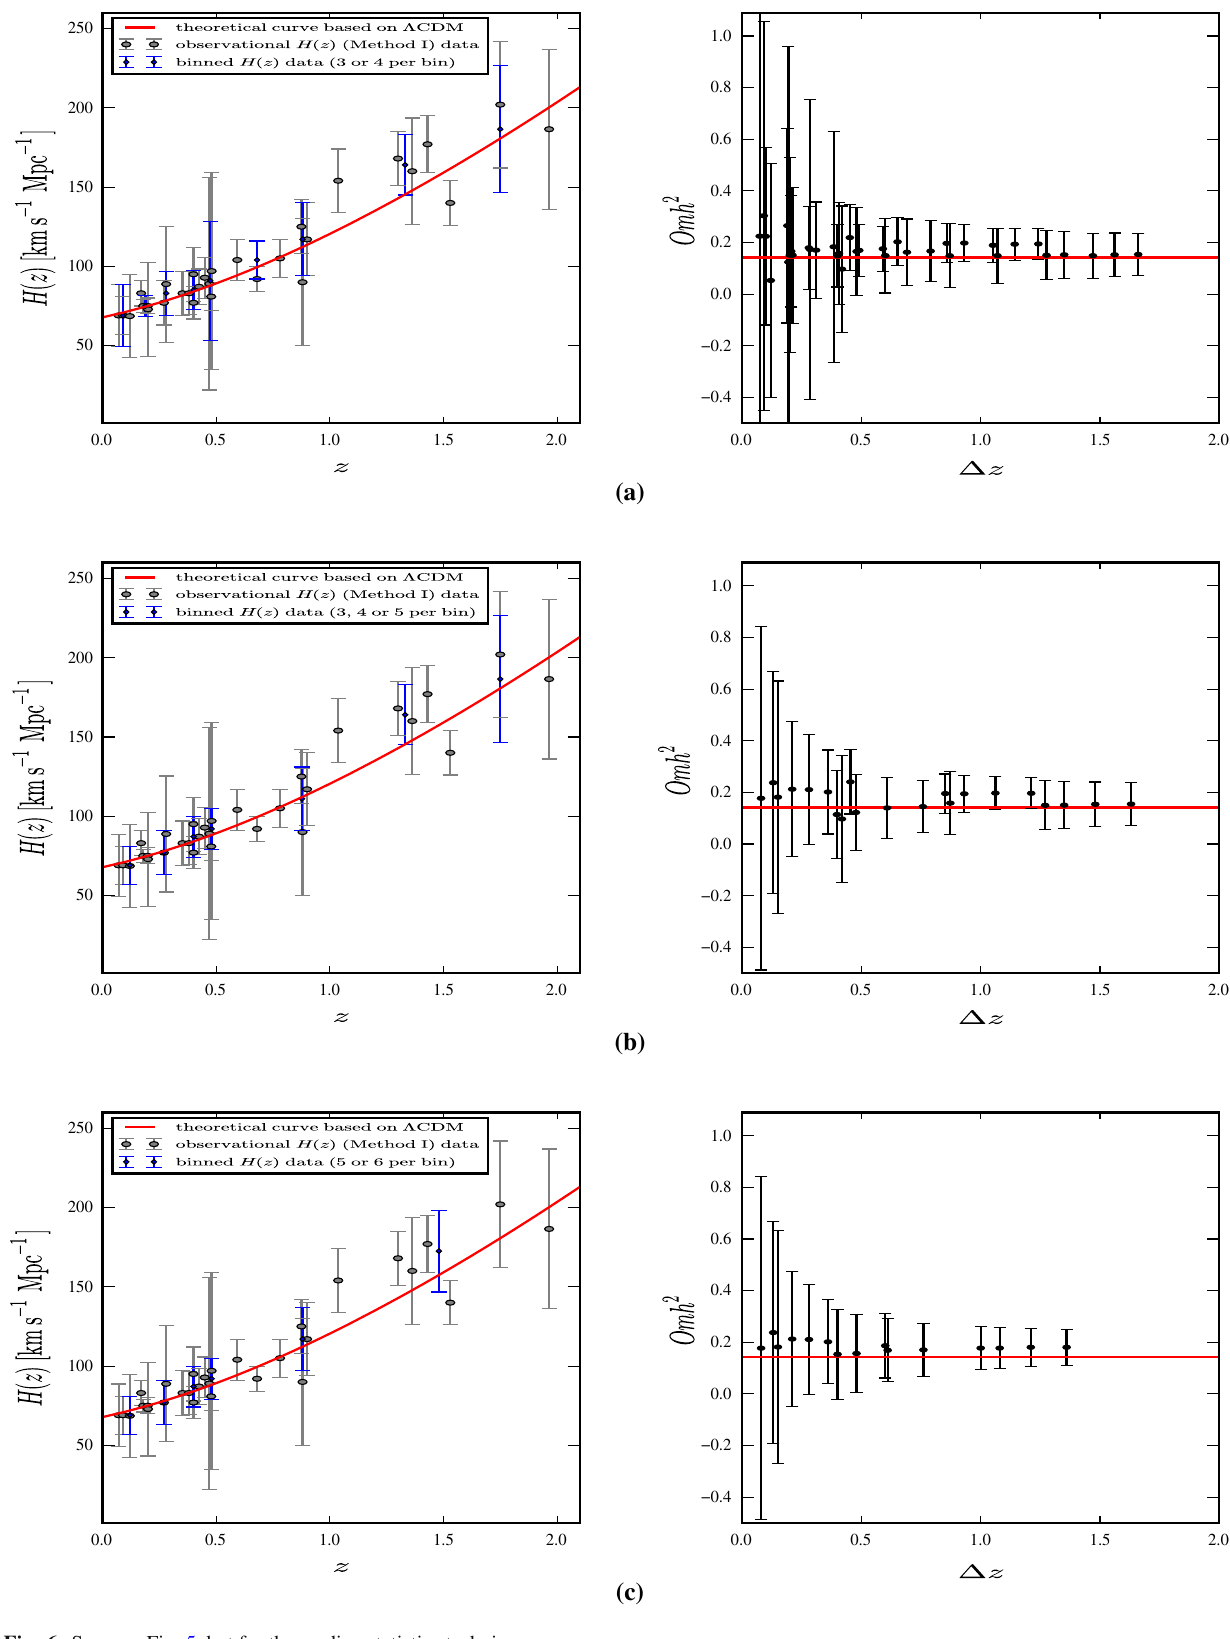
Fig. 6 Same as Fig. 5, but for the median statistics